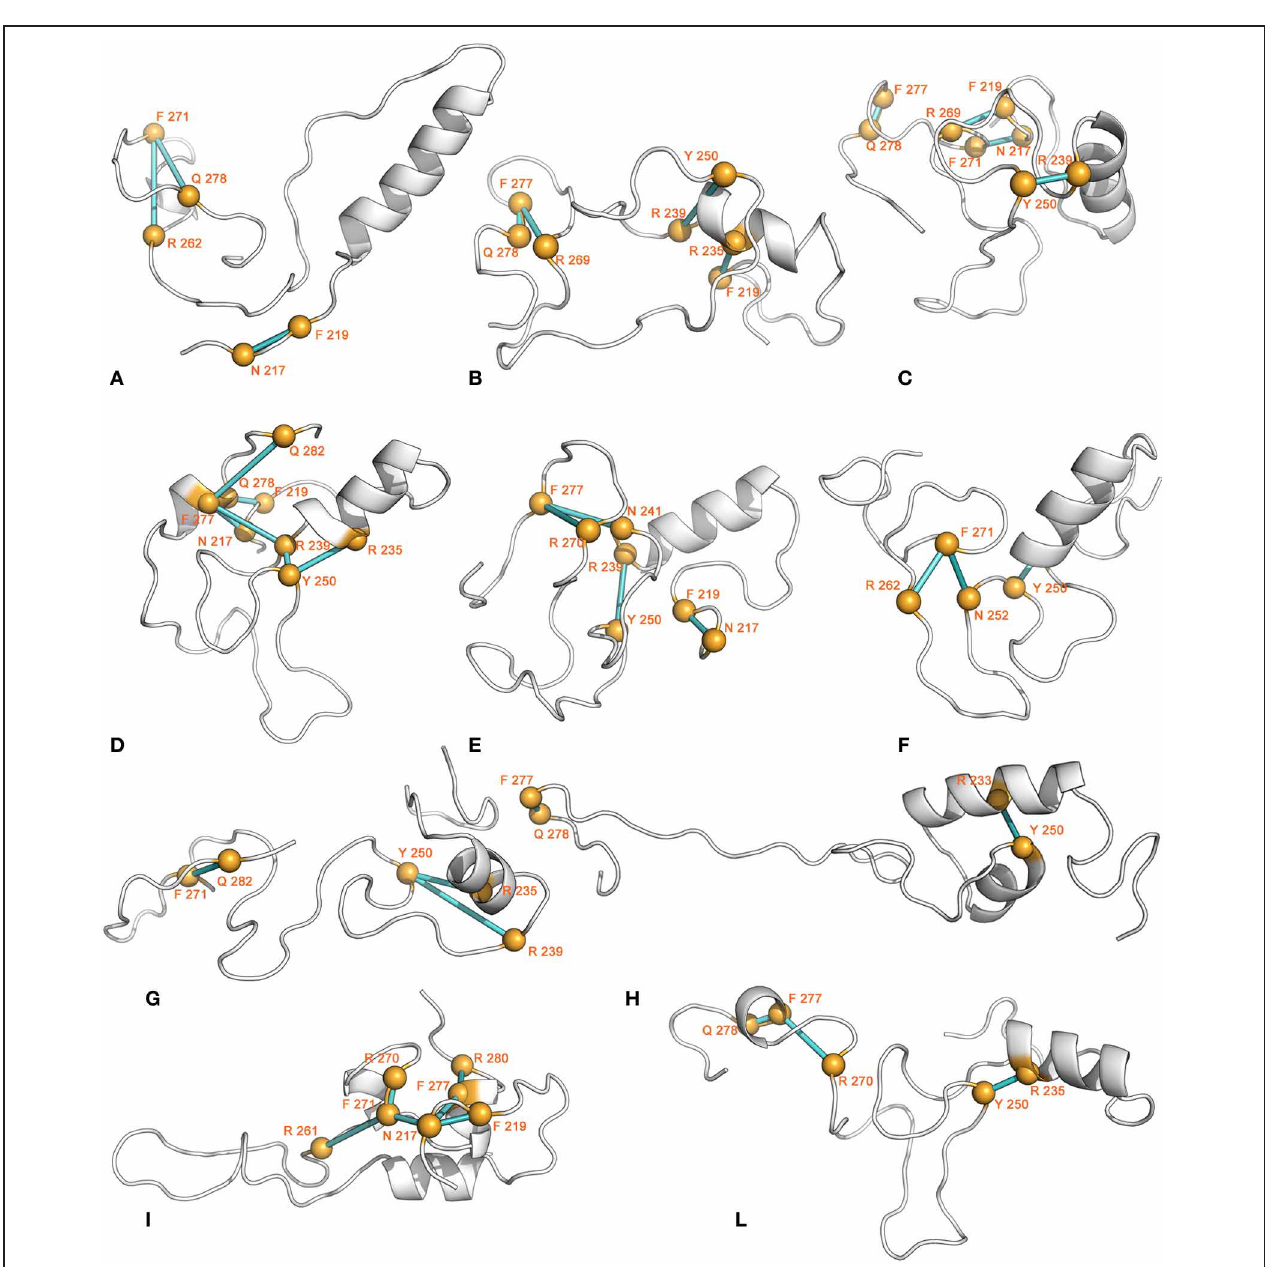
FIGURE 12 | Amino-aromatic interactions. The 3D average structure of each conformational basin is shown as cartoon, and the C α atoms of the residues involved in amino-aromatic interactions are shown as yellow